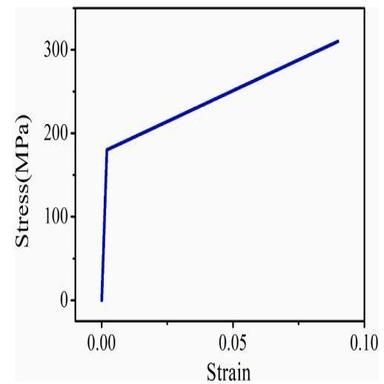
Bi-linear elastic–plastic strain–stress curve of H-62 brass.